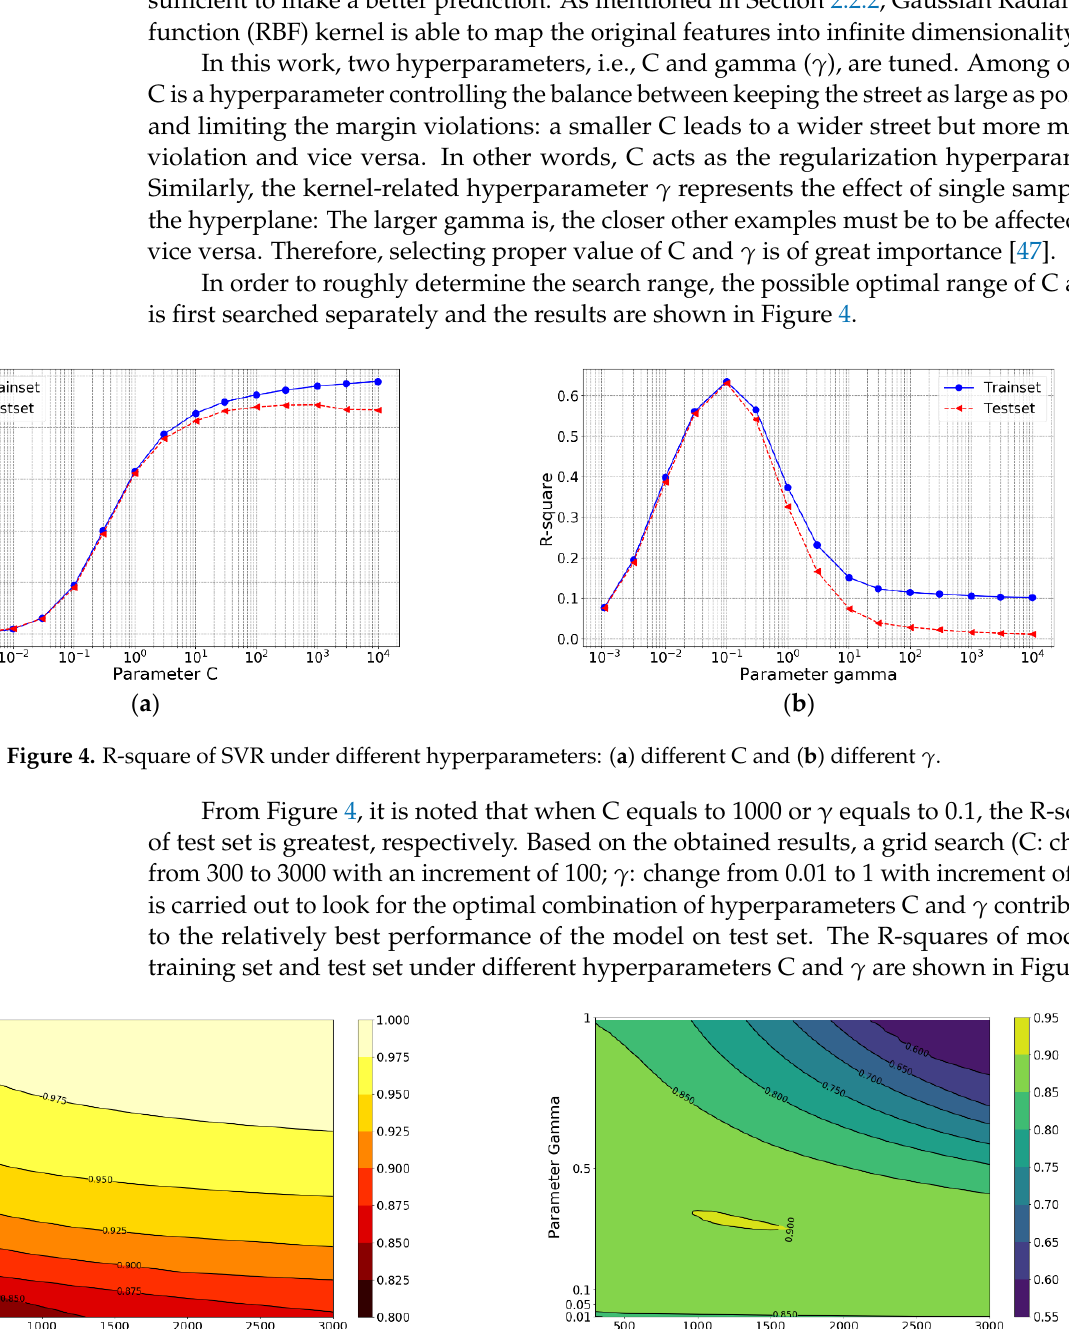
( b ) Figure 3. Prediction accuracy of 3rd degree polynomial LR model on ( a ) training set and ( b ) test set. From Figure 3, the performance of LR model with polynomial degree of 3 is remark-